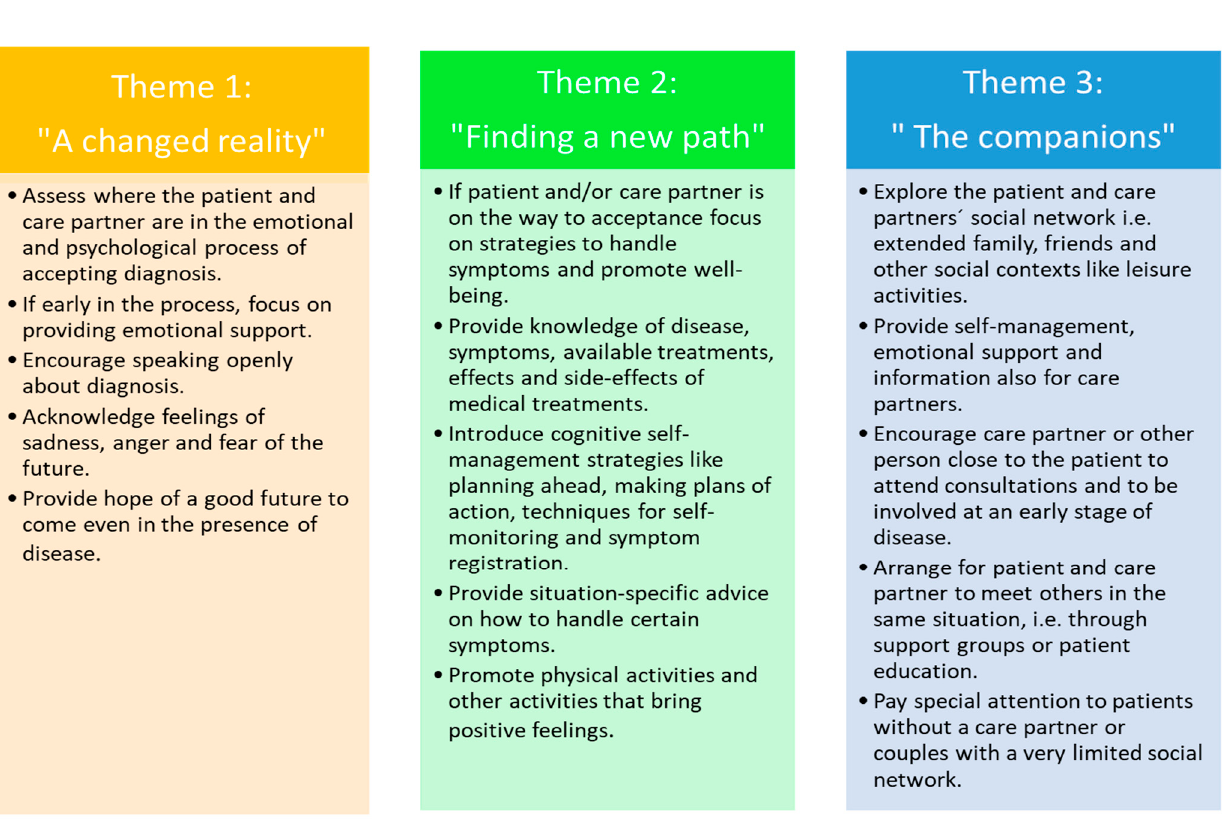
Figure 3. Nursing interventions connected to the themes.